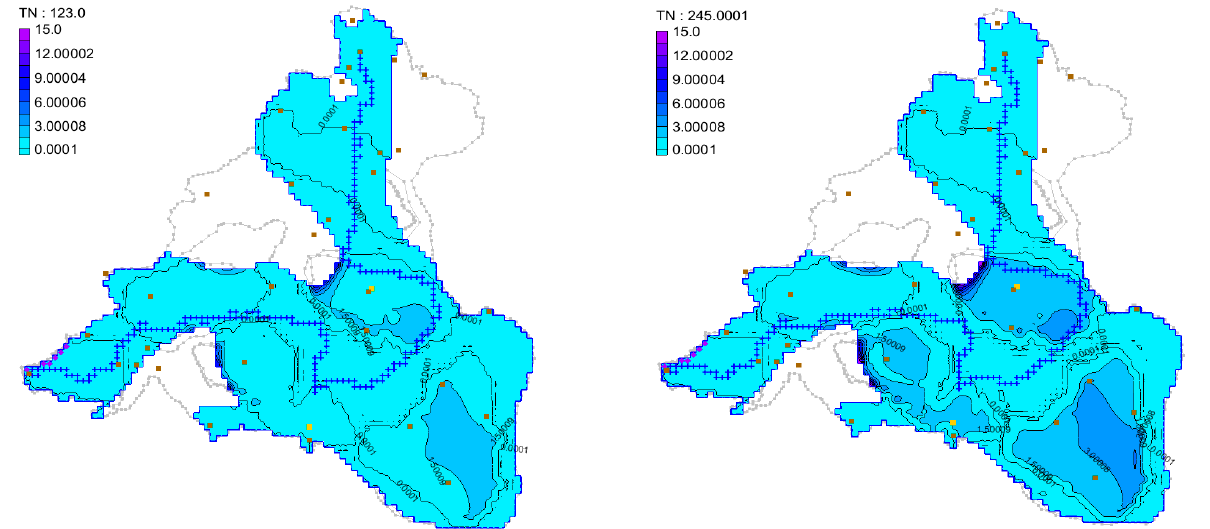
Figure 6. Scenario 2 model of 123 d and 245 d total nitrogen simulation results. Table 4. Reduction in the proportion of total nitrogen concentration in rivers in Scenario